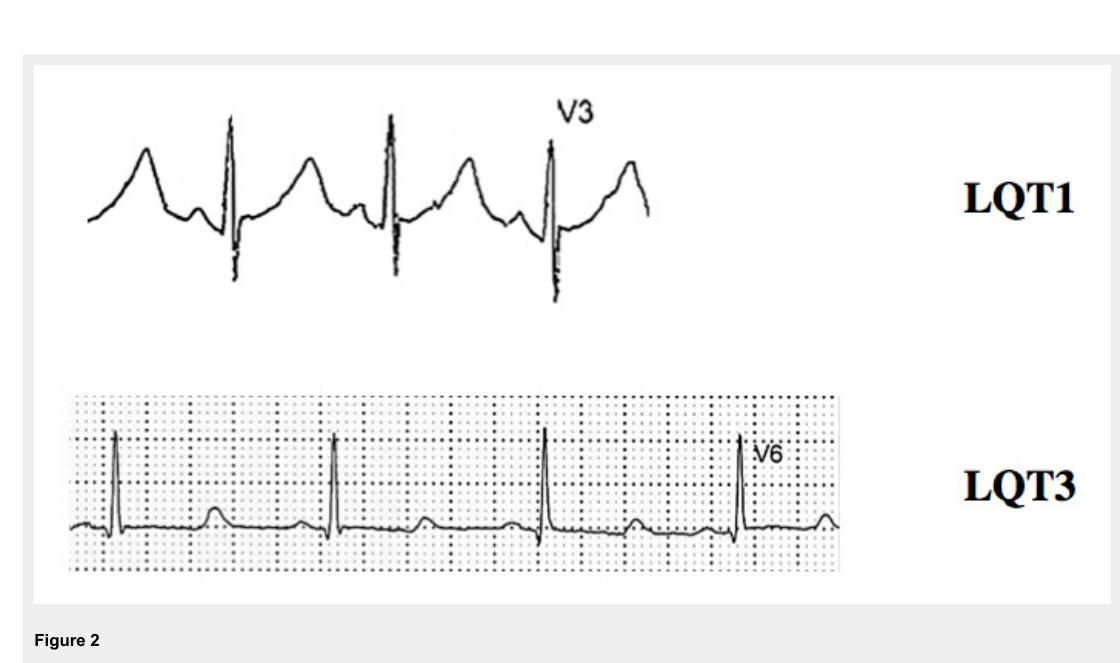
(A) Example of notched T waves from a 37-year old man affected by long QT syndrome (LQTS) who suffered two syncopal episodes. (B) Example of T wave alternans from a 2-year old LQTS patient with multiple episodes of cardiac arrest. Both tracings are from a 24-hour Holter recording. (Reproduced from reference